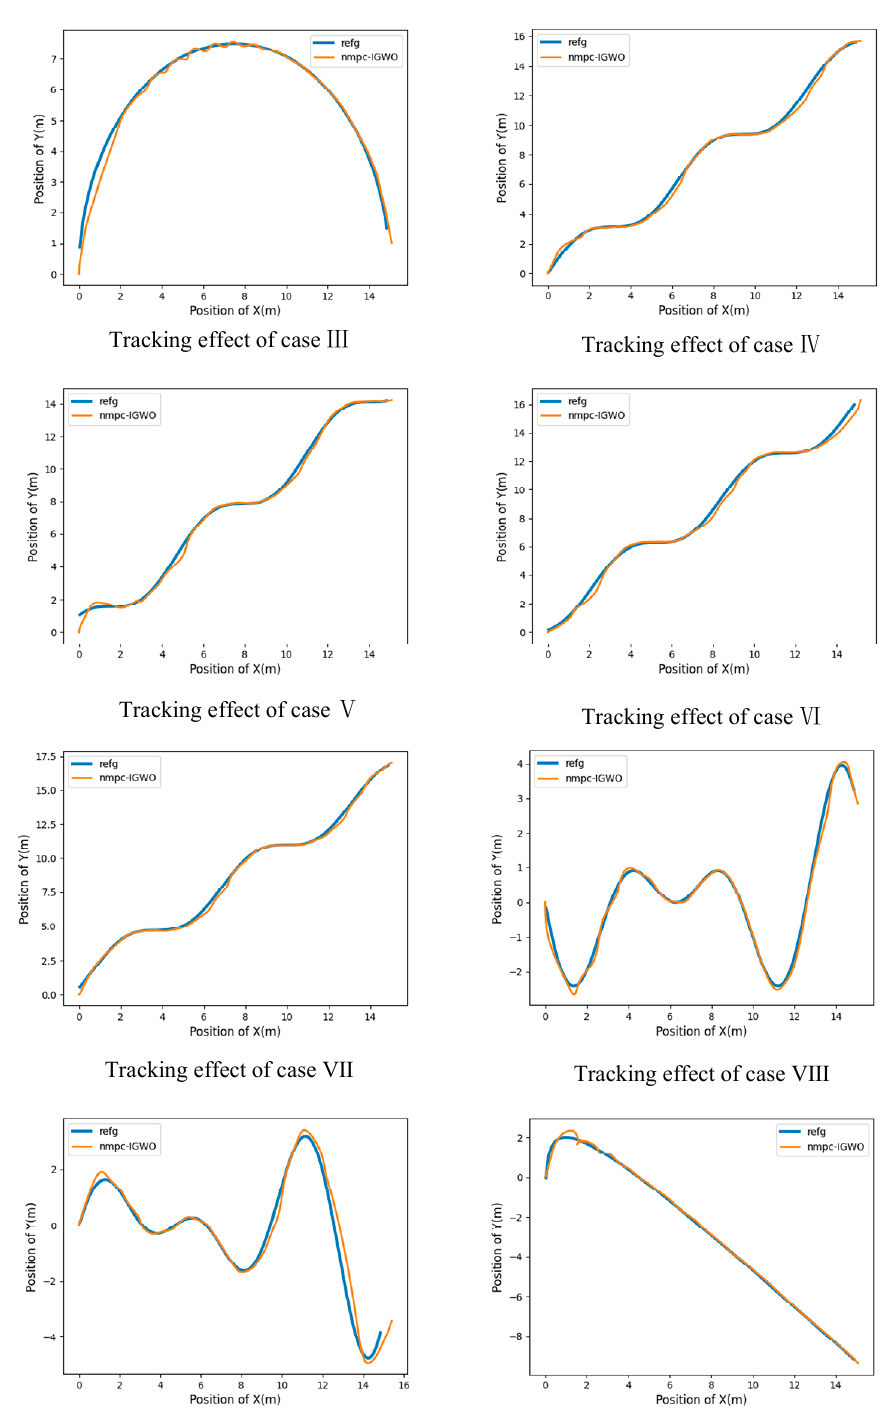
Figure 10. Tracking effects of other reference trajectories.